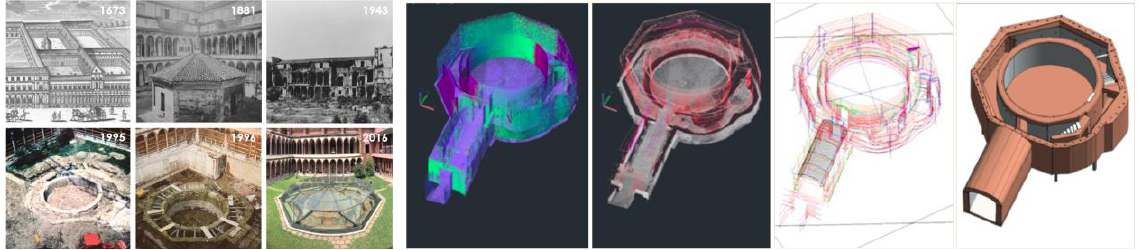
Fig. 1. The ice house of Filarete’s Ospedale Maggiore today and in the past (left); an overview of the workflow for Building Information Modelling for built environments with complex forms